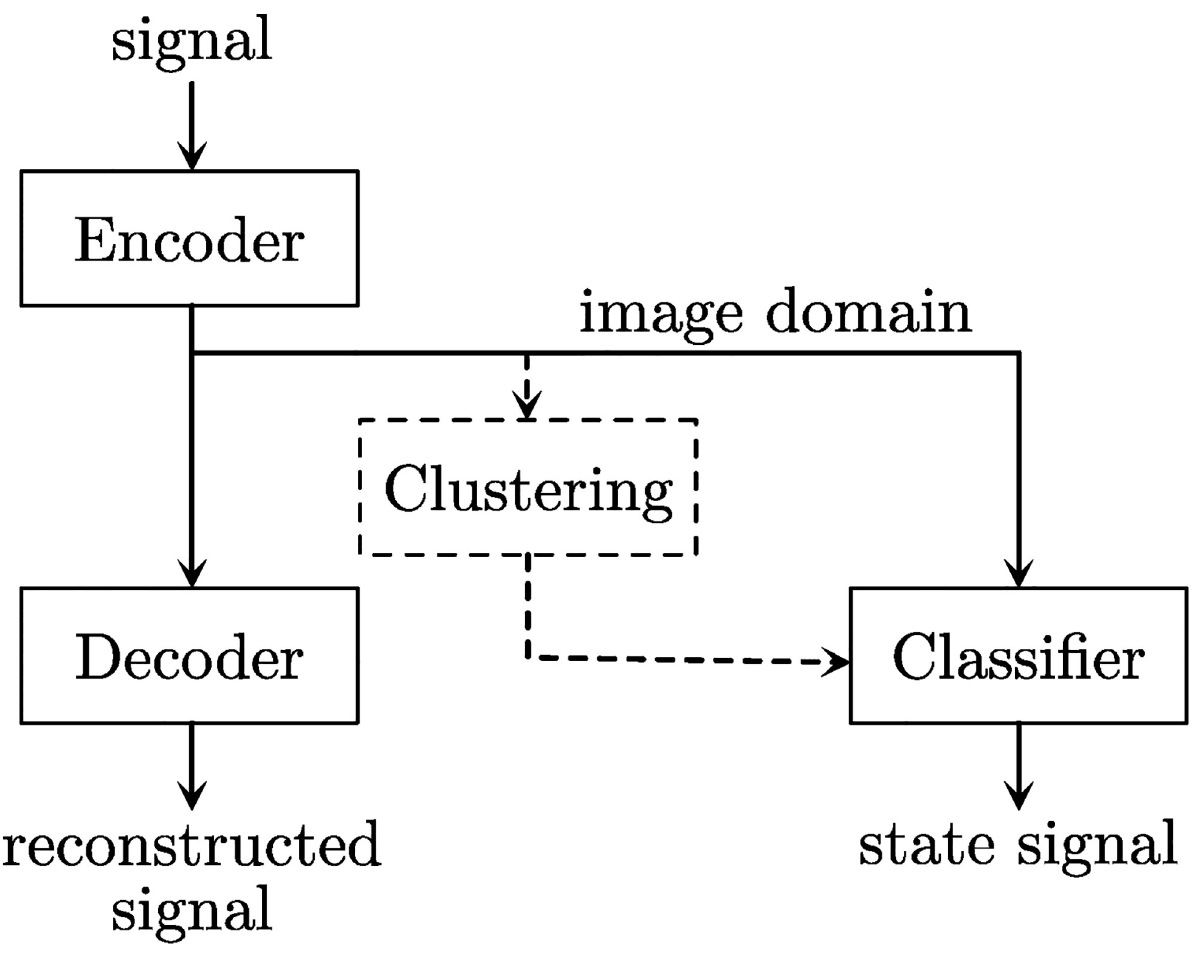
Fig 5. Schematic illustration of the autoclassifier